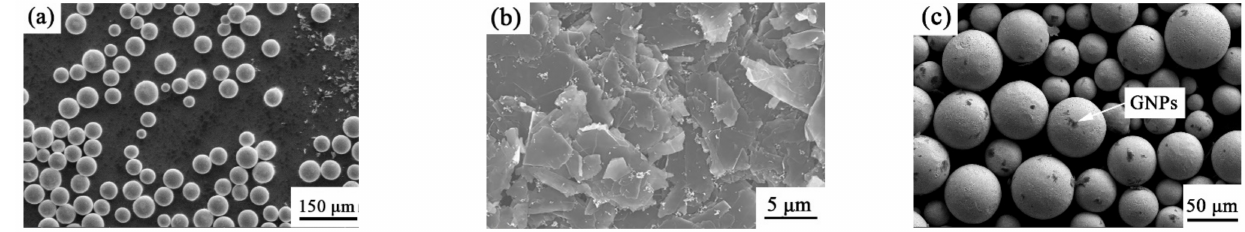
Figure 11. SEM morphological images: ( a ) TC11 powder; ( b ) GNPs; and ( c ) GNPs/TC11 composite